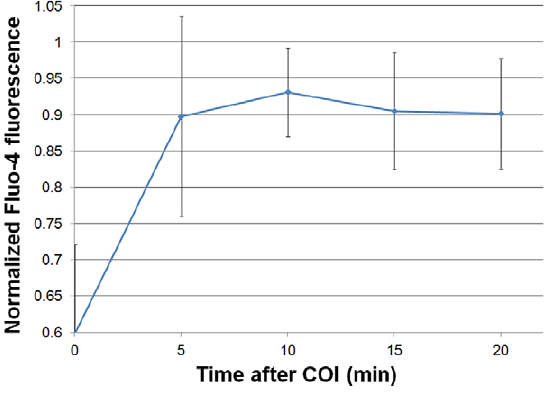
Figure 8. Cytosolic Ca 2 + ions elevation in bystander cells. bEnd.3 monolayers were incubated with Fluo-4, for Ca 2 + staining, subjected to COI and then followed by TLFM at 5min intervals. The plot illustrates the maximal normalized Fluo-4 emission intensity in n=5 bystander cells close to the rim of the COI rectangle.